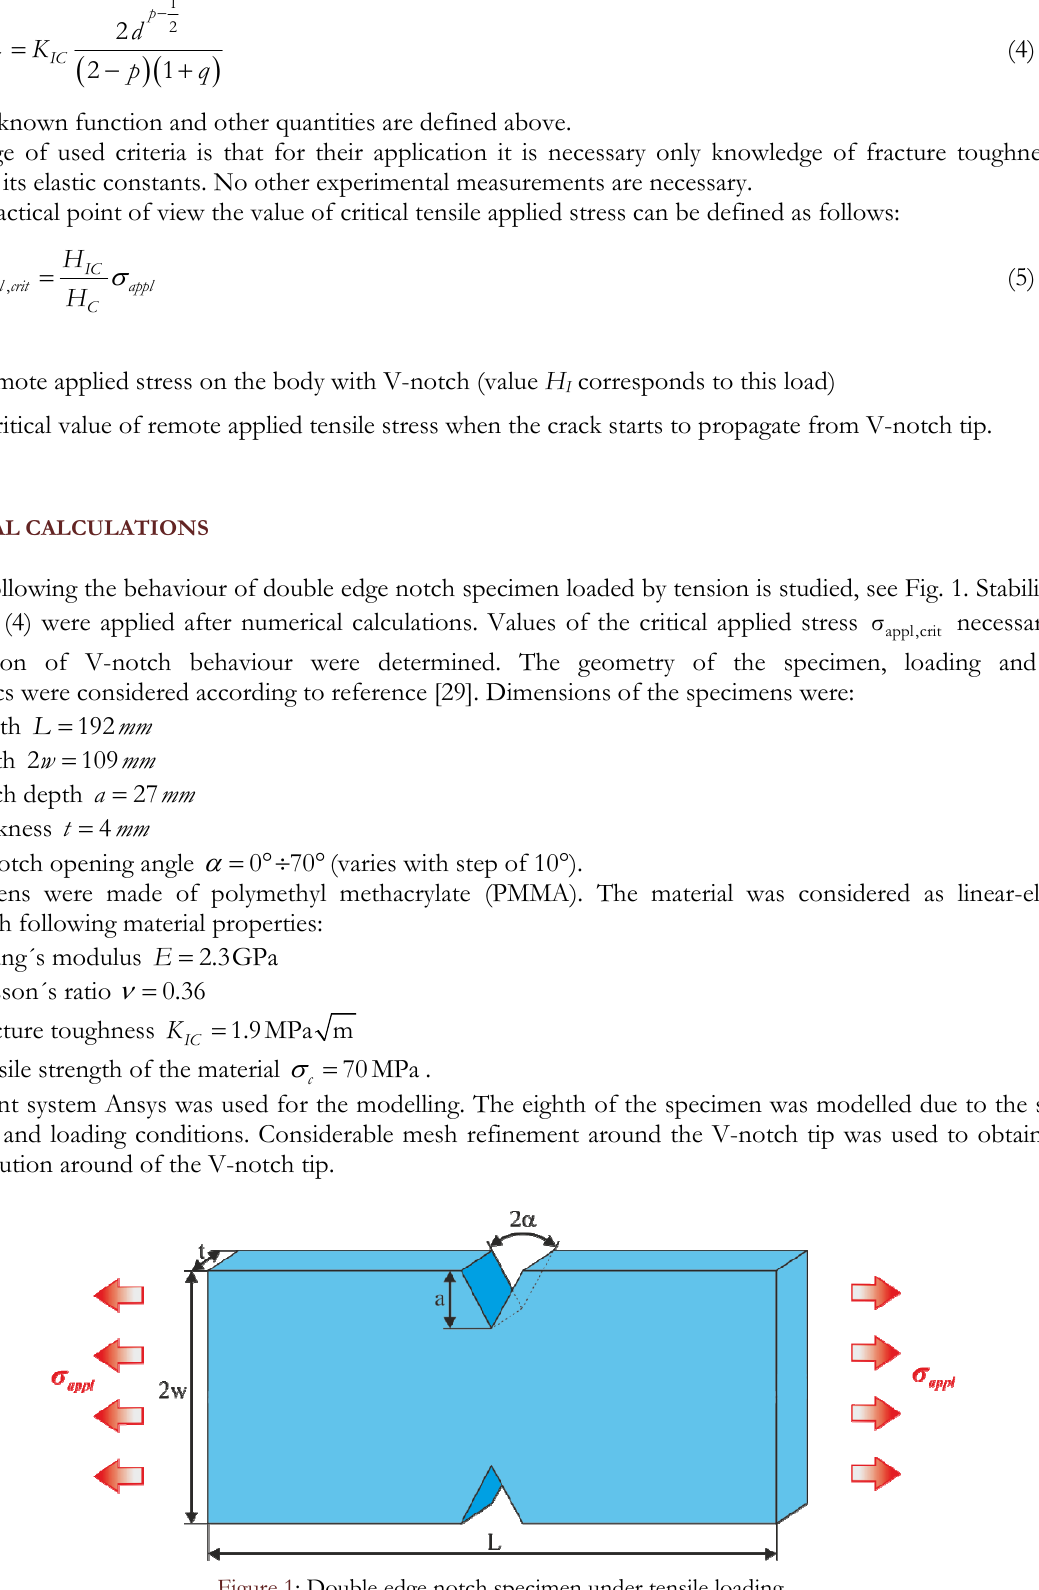
Figure 1: Double edge notch specimen under tensile